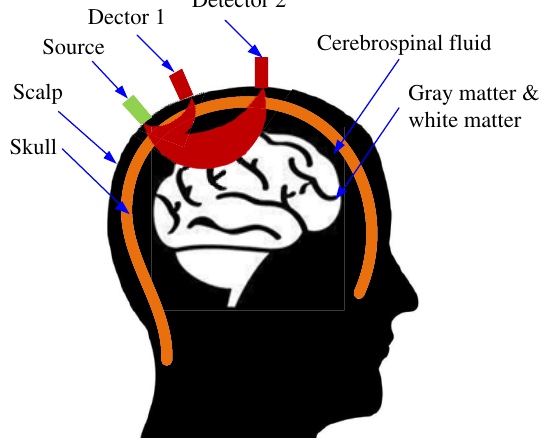
Fig. 2. Schematic of a multi-distance fNIRS probe arrange- ment together with the ¯ve layer model of the